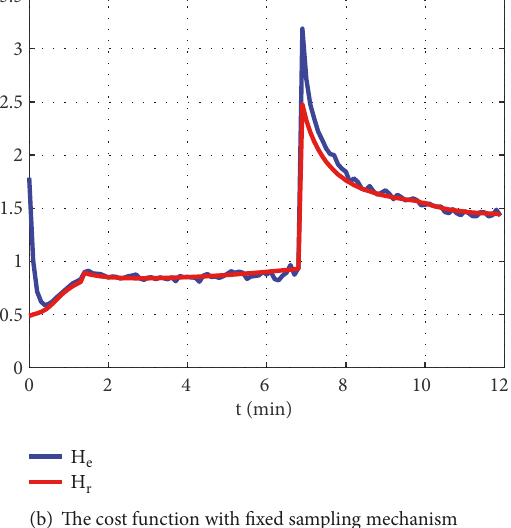
(b) The cost function with fixed sampling mechanism Figure 4: The evolution of the cost